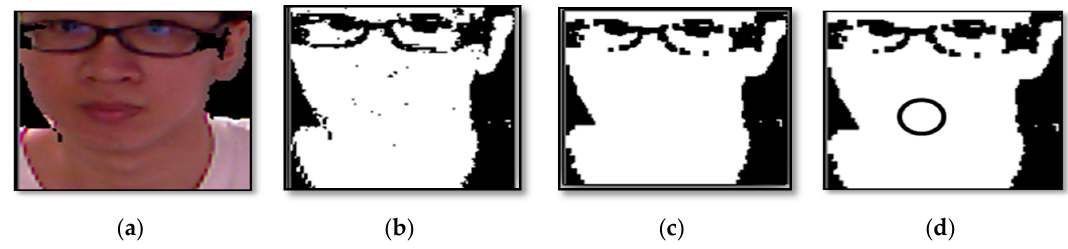
Figure 9. Skin detection process: ( a ) RGB image, ( b ) Elliptical skin model, ( c ) Morphological close, and ( d ) Largest connected object.